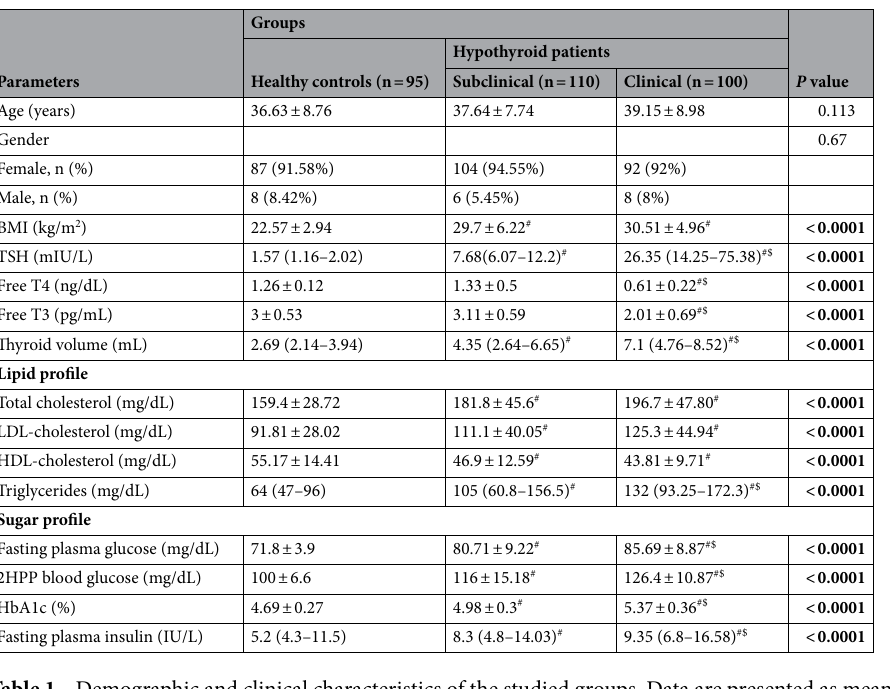
Table 1. Demographic and clinical characteristics of the studied groups. Data are presented as mean ± SD, median (25–75% percentiles) or number (percentage). BMI: body mass index, HbAIc: glycated hemoglobin, 2HPP: 2-h postprandial, TSH: thyroid stimulating hormone. # Statistical significance from healthy controls, $ Statistical significance from subclinical hypothyroid patients. P values of ANOVA or Kruskal Wallis tests (when appropriate) across the three groups are presented. Bold means statistical significance between groups, P < 0.05.